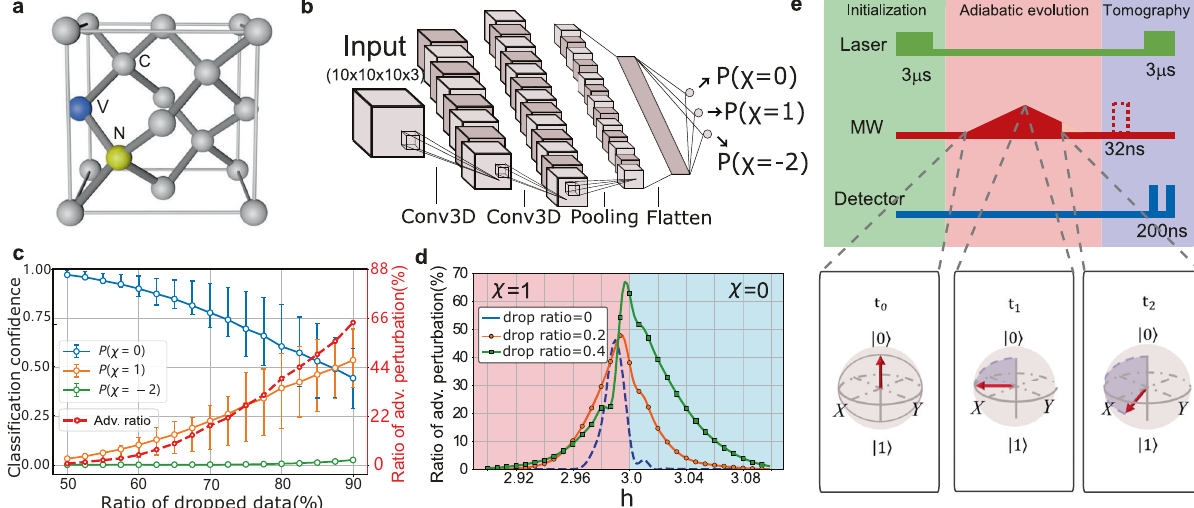
Fig. 1 | Experimental setup and the topological phase classi fi er. a The structure of a nitrogen-vacancy center in a diamond crystal. The blue, yellow, and gray spheres represents vacancy, nitrogen, and carbon atoms, respectively. b The structure of 3D convolutional neural network (CNN) classi fi er. The input data are density matrices sampledfrom a 10×10×10 regular grid inthe momentum space, and each density matrix is represented by three real indices among the Bloch sphere. With two 3D convolution (Conv3D) layers, one max pooling layer and one fullyconnected layer,the classi fi er outputs the probabilities P ( χ =0,1, − 2)for each phase. c The potential limitation of the CNN classi fi er on data with random drop- ping.Theclassi fi ercancorrectlyclassifythecleandataoftopologicallytrivialphase ( h =3.2, χ =0)withmorethan80%ofthedatasamplesdropped,buttheadversarial